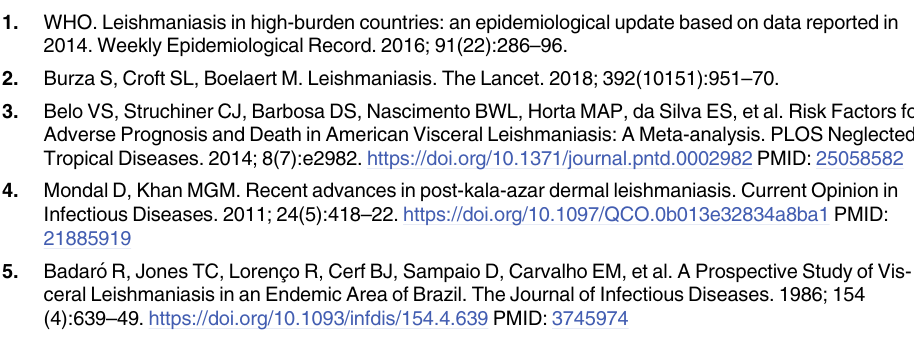
S4 Fig. Analysis of 16S rRNA genetic diversity for live bacteria present in hamster liver tis- sue samples, skin swabs and environment. (TIF) S5 Fig. Evaluation of the impact of oral vancomycin or rifaximin monotherapy on hamster VL outcomes.